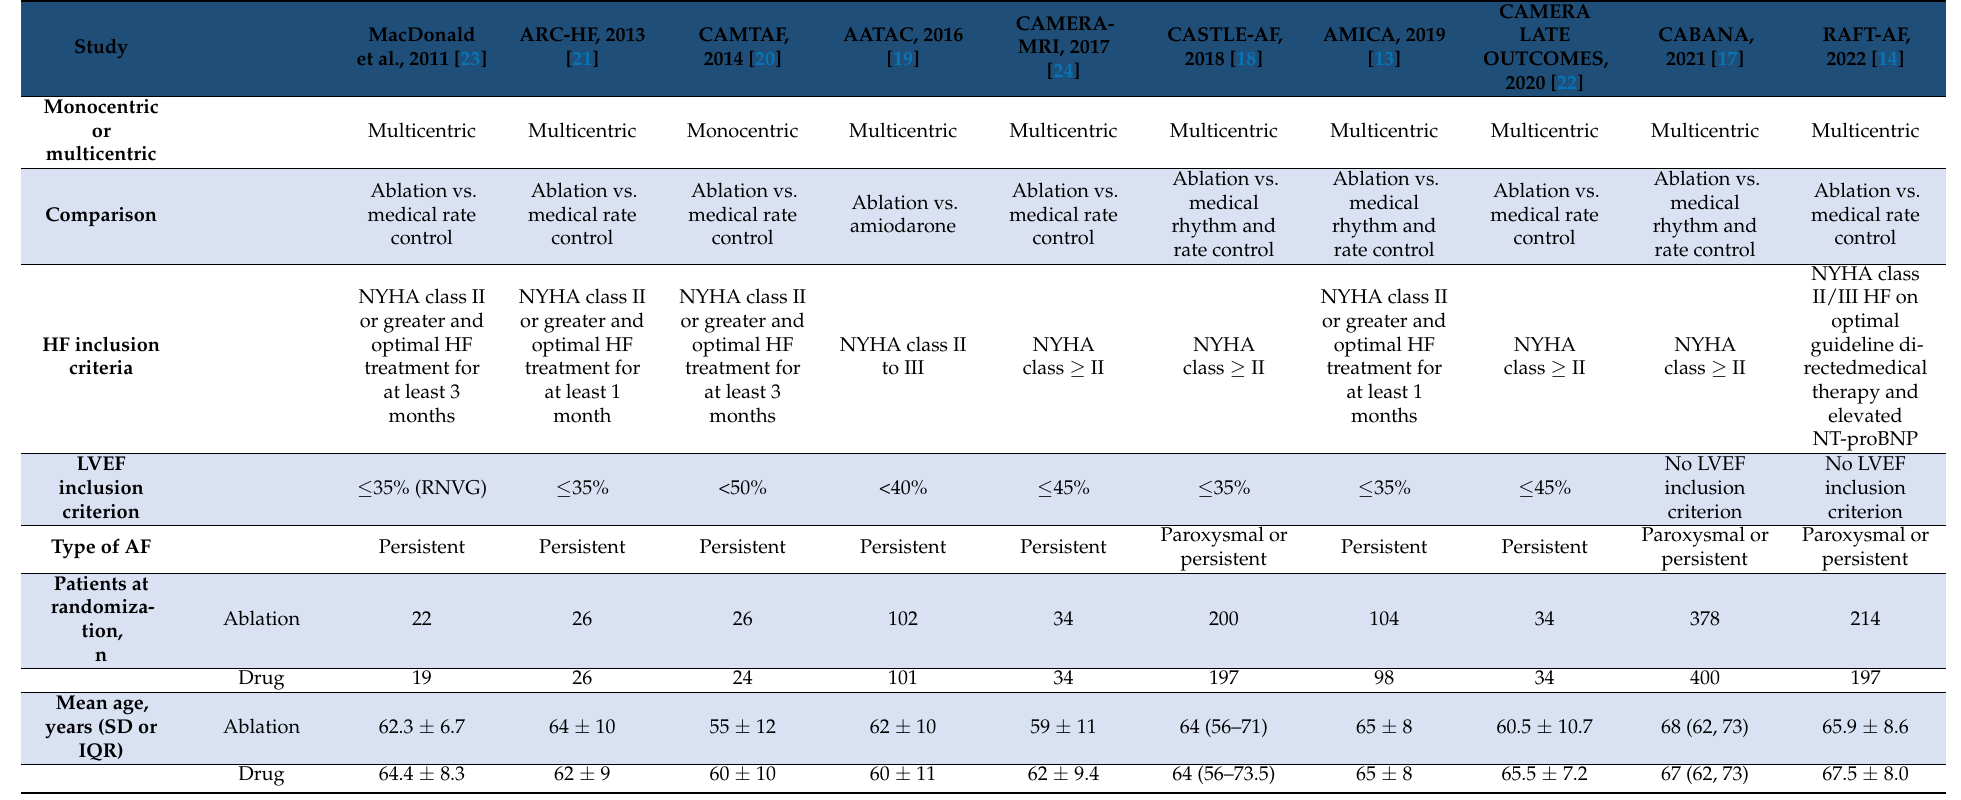
Table 1. Study Baseline Characteristics of Patients Included in the